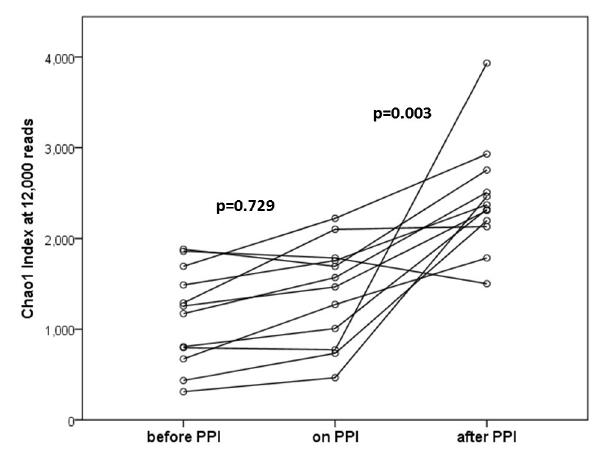
FIGURE 1 | α -diversities (Chao1 index at 12,000 reads) at the three time points tested ( n = 12 per time point). In the within-individual comparison there was no statistically significant difference after 4 weeks of PPI treatment ( p = 0.729). Four weeks after discontinuation of PPI therapy α -diversities were significantly increased ( p = 0.003 for “after PPI” vs. “before PPI” and “on PPI.” Lines connect individuals.